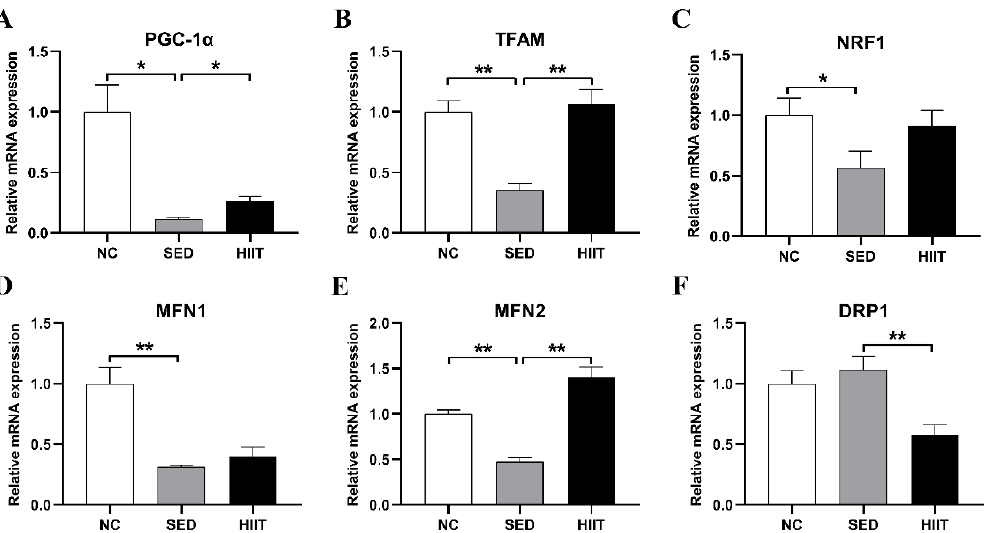
Figure 8. HIIT improves liver mitochondrial biosynthesis and dynamics in T2DM mice. ( A – F ) The mRNA expression levels of PGC-1 α , TFAM, NRF1, MFN1, MFN2, and DRP1. Values are mean ± SEM (n = 8 per group). * p < 0.05, ** p < 0.01.